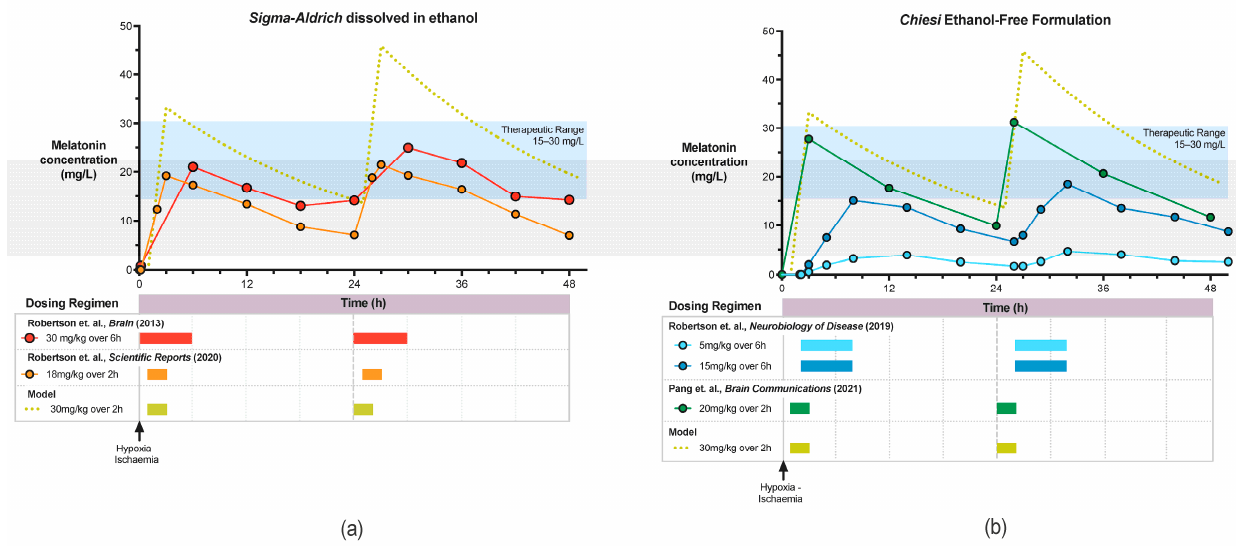
Figure 3. Pharmacokinetic Profile of Sigma-Aldrich Melatonin dissolved in ethanol ( a ) and Chiesi ethanol-free melatonin ( b ).